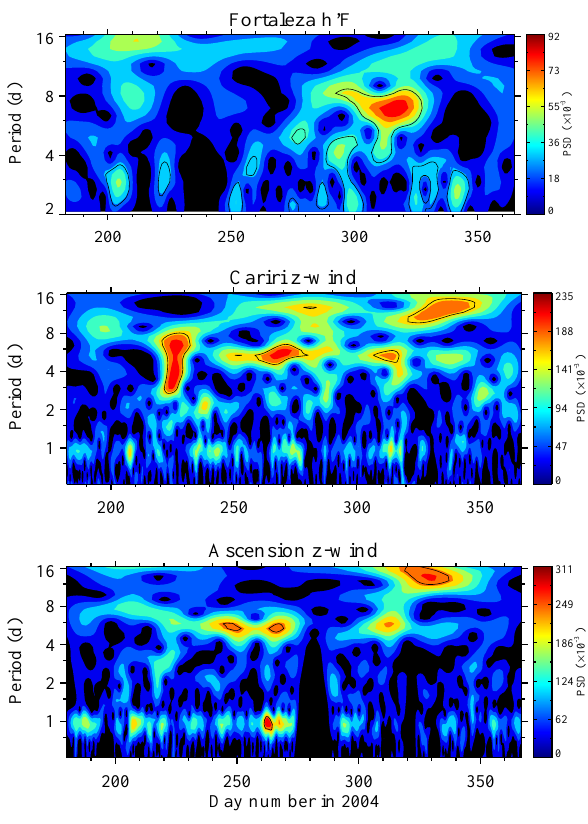
Fig. 4. Wavelet power spectrum of the ionospheric h 0 F day-to-day variation at 23:00 UT at Fortaleza (top), the zonal winds at 90km at Cariri (middle) and at Ascension Island (bottom). The color shade shows spectral power density. The full lines indicate the 90% sig- nificance level.